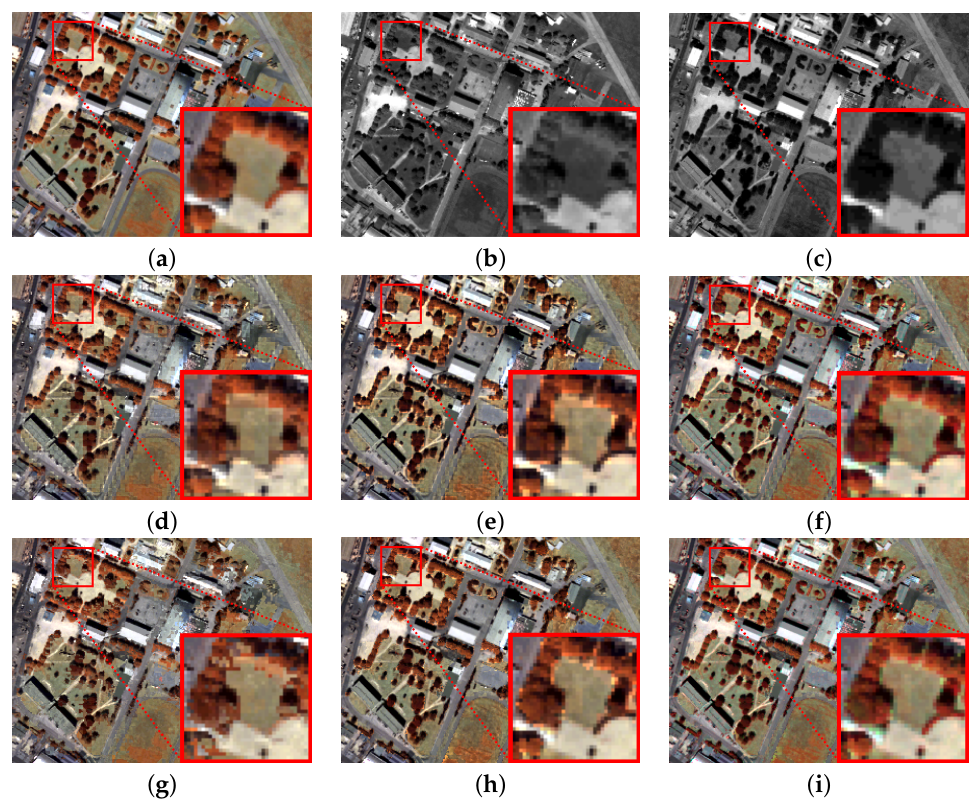
Figure 8. “Toulon” peri-urban dataset: global visual results (SWIR colour composite images; spatial resolution: 1.5 m; Gain-2P limit in brackets). ( a ) REF, ( b ) PAN visible, ( c ) PAN SWIR II, ( d ) Gain, ( e ) Gain-2P (0.95 µ m), ( f ) Gain-2P (1.35 µ m), ( g ) CONDOR, ( h ) CONDOR-2P (0.95 µ m), and ( i ) CONDOR-2P (1.35 µ